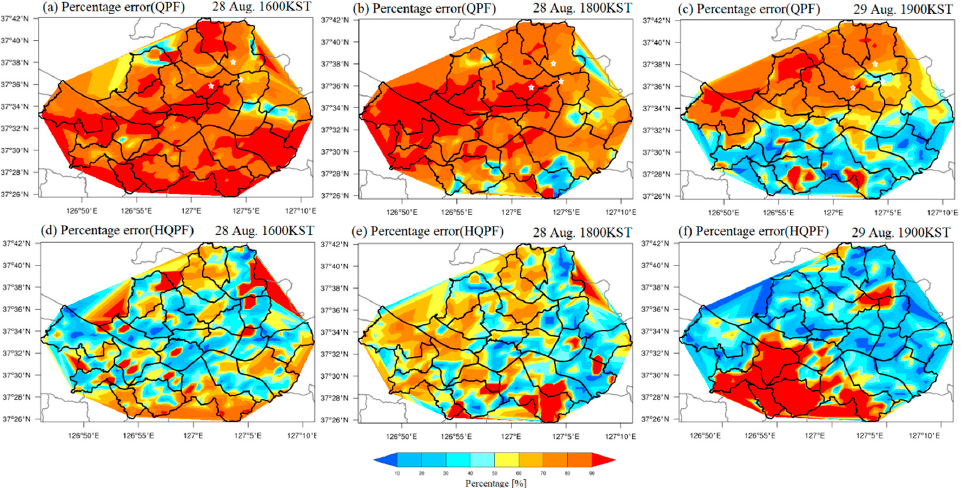
Figure 8. Spatial distribution of percentage error derived from ( a – c ) QPF-based rainfall and ( d – f ) HQPF-based